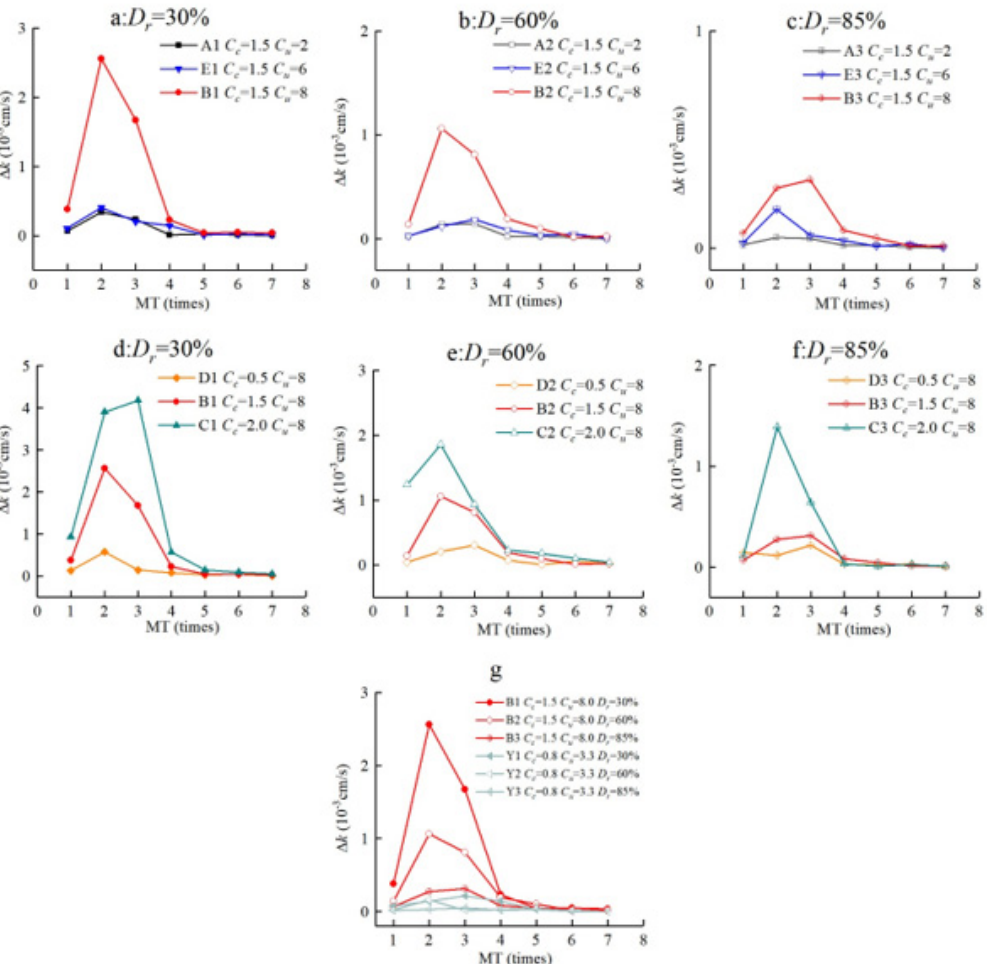
Figure 7. Permeability coefficient difference ( ∆ k ) vs. cycles of MICP treatment (MT) of sand at different gradations and compactness ( D r ): ( a ) D r = 30% for samples A1, B1 and E1; ( b ) D r = 60% for samples A2, B2 and E2; ( c ) D r = 85% for samples A3, B3 and E3; ( d ) D r = 30% for samples B1, C1 and D1; ( e ) D r = 60% for samples B2, C2 and D2; ( f ) D r = 85% for samples B3, C3 and D3; ( g ) samples B and